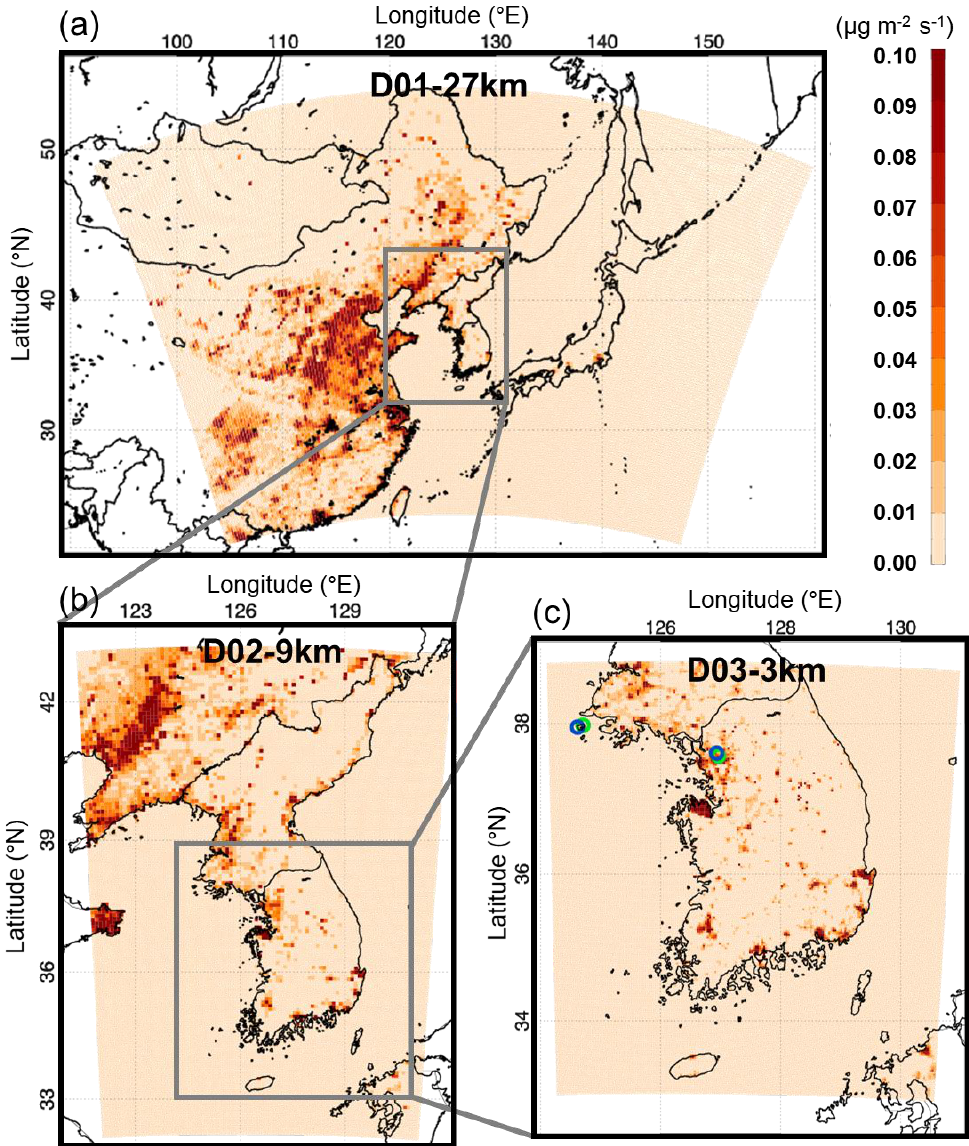
Figure 1. Primary PM 2.5 emissions averaged for May 2016 and three nested domains used in WRF-Chem simulations, i.e., ( a ) D01 (27-km grid spacing for Northeast Asia), ( b ) D02 (9-km grid spacing for Korean Peninsula), and ( c ) D03 (3-km grid spacing for South Korea), and the locations of two monitoring sites, i.e., Seoul-Bulgwang (urban) and Baengnyeongdo (background) sites used for 4 chemical components, i.e., SO 42 − , NO 3 − , NH 4 + , and OC in this study. The green and blue circles in D03 domain, respectively, indicate the locations at which the meteorological observation data and aerosol concentration data were measured to verify the model simulations.